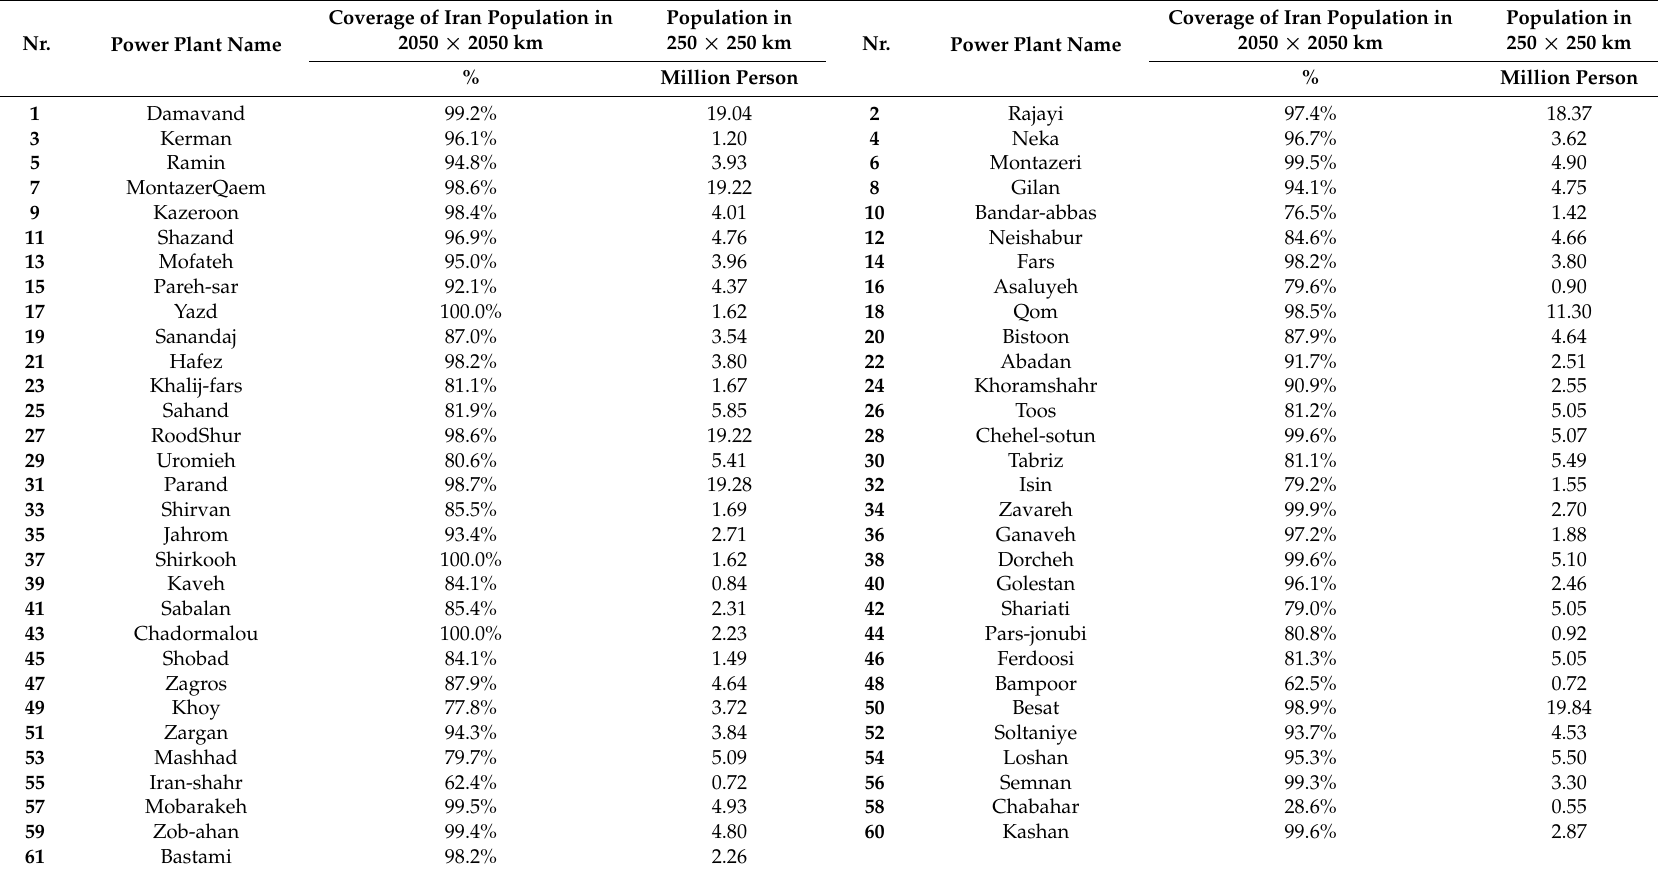
Table A1. Summary of status of population around of the selected power